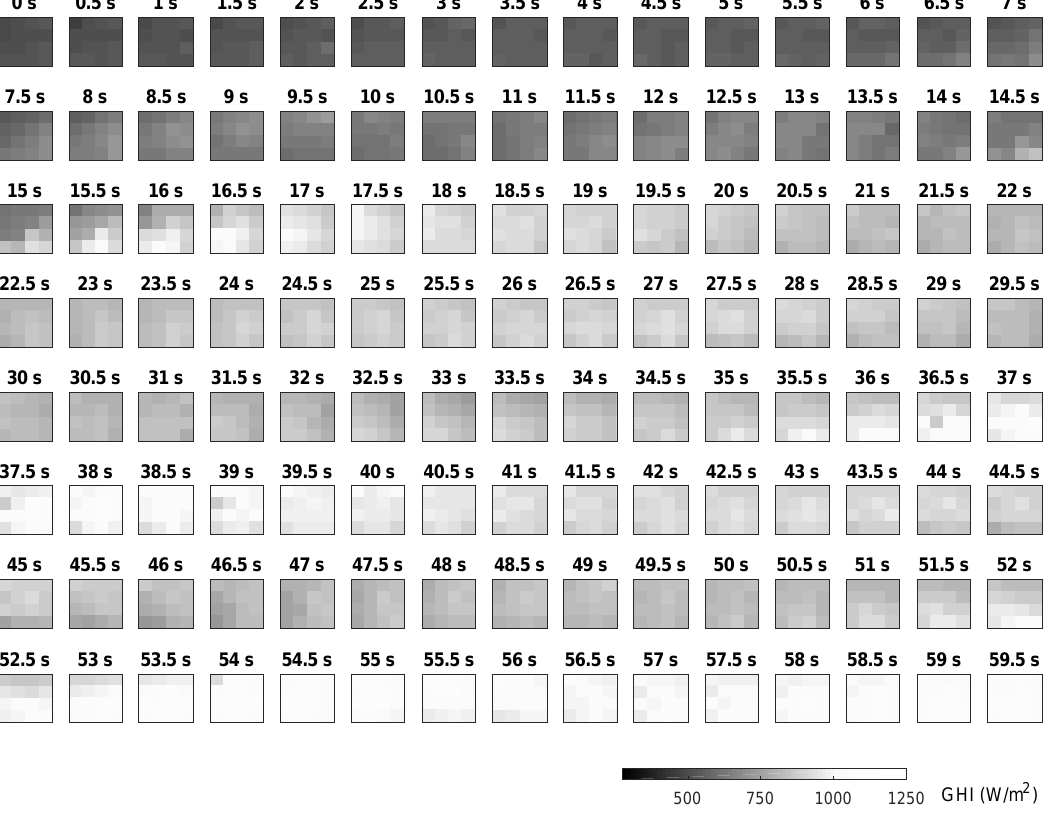
Figure 9. Irradiance field sequence of 60